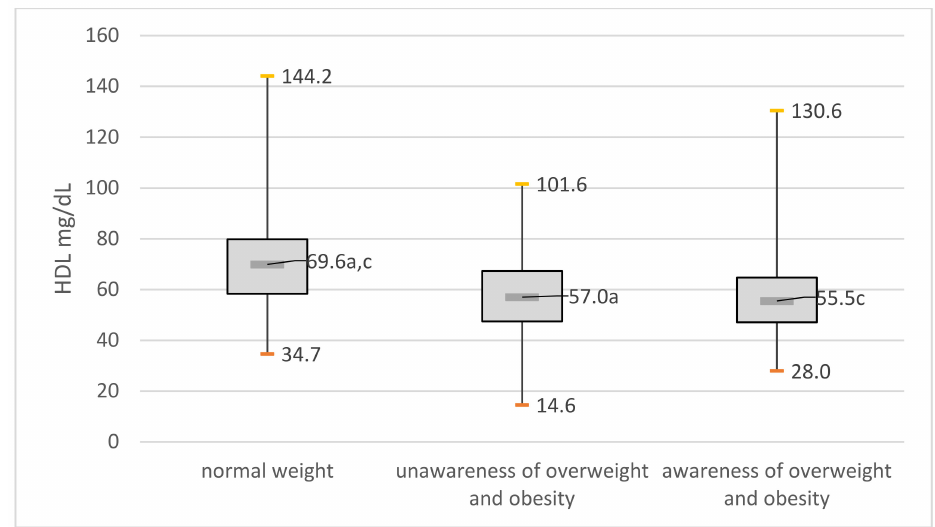
Figure 3. High-density lipoprotein (HDL) in the compared groups: (a) significant difference between group with normal weight and group unaware of overweight and obesity; (c) significant difference between group normal weight and group aware of their overweight and obesity.